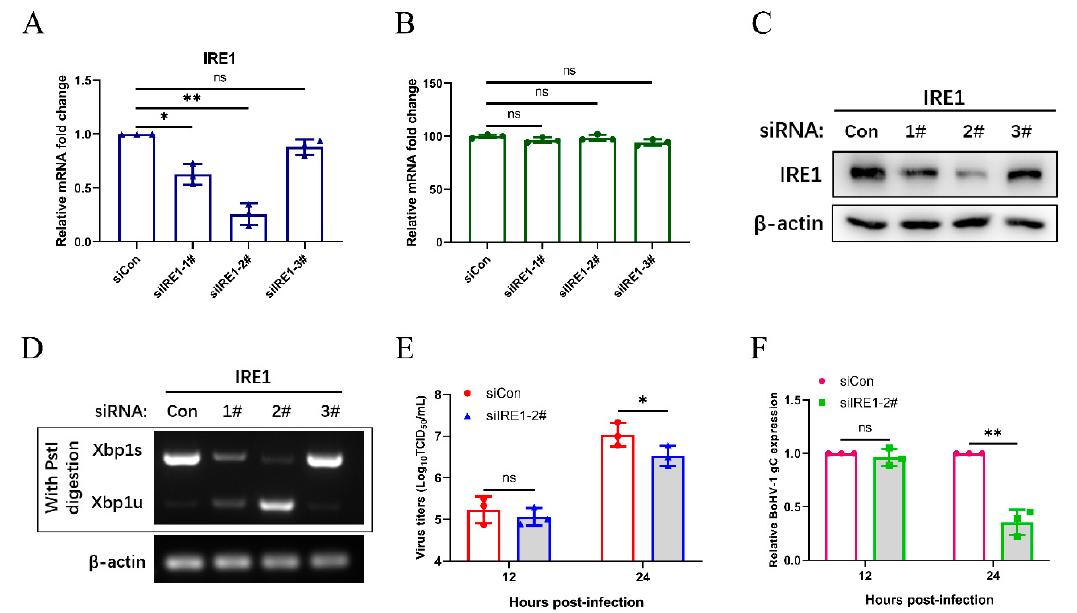
Figure 5. The IRE1 pathway induced by BoHV-1 infection promotes viral replication in MDBK cells. ( A ) The silencing efficiency of IRE1 was measured by qPCR in MDBK cells at 24 h post-transfection. ( B ) The CCK-8 assays were used to analyze the viability of MDBK cells 24 h after transfection. ( C ) Immunoblot analysis of the silencing efficiency of IRE1 at 48 h post-transfection. ( D ) At 48 h siRNA duplexes post transfection, MDBK cells were challenged with BoHV-1 (0.1 MOI) and then harvested at 24 hpi for XBP1 splicing assay. ( E , F ) At 48 h siCon or siIRE1 post transfection, MDBK cells were infected with BoHV-1 (0.1 MOI) and harvested at the indicated time points for virus titration analyses and viral gene expression analyses. The mean ± SD of data from three independent experiments are shown; * p < 0.05, ** p <